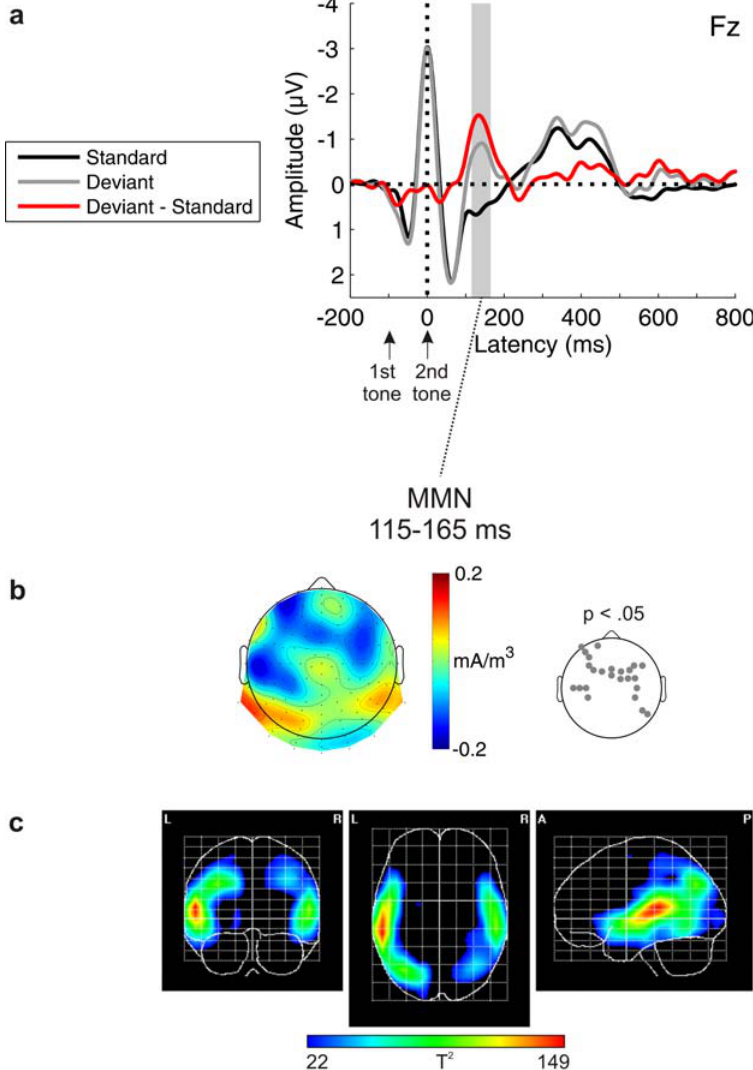
Figure 1. Ignore condition for abstract rules. a) Grand-average ERPs elicited by standards (black) and deviants (gray), and deviant minus standard difference wave (red). b) Topographic distribution of the MMN component (scalp current density, SCD). Electrode positions with SCD values significantly deviating from zero are indicated in the p-value map. c) Tomographic distribution of the MMN component (primary current density, PCD). The hotter colors correspond to higher probability values (one-way ANOVA; thresholded to p ,